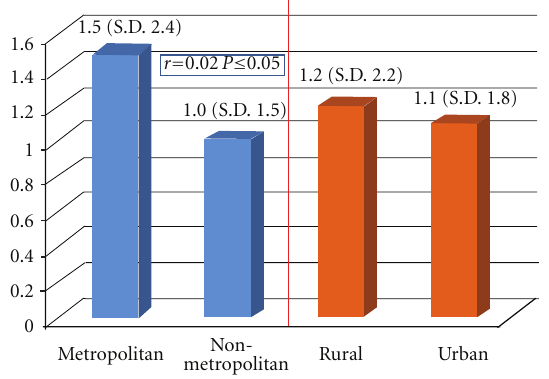
Figure 2: The mean additive OHIP-14 score (SD) according to